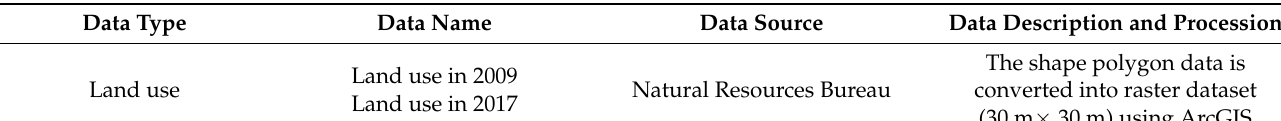
Table 1. Data source and relative data